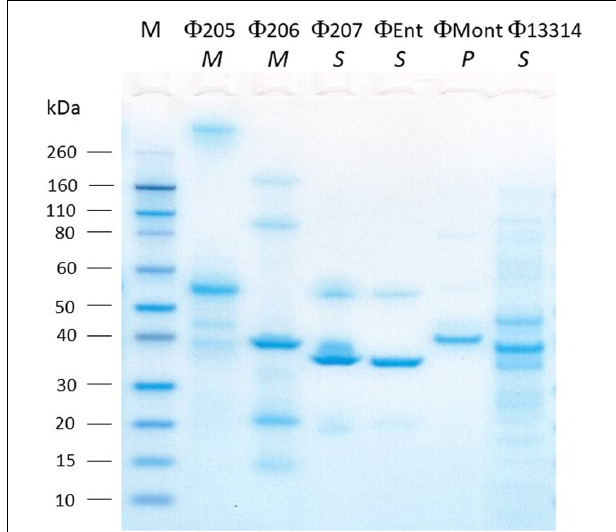
FIGURE 2 | SDS-PAGE analysis of the structural proteins of six Salmonella phages isolated from turkeys. Lane M, molecular mass standard. The italicized letters ( M , S , and P ) below phage names stand for Myoviridae , Siphoviridae , and Podoviridae ,